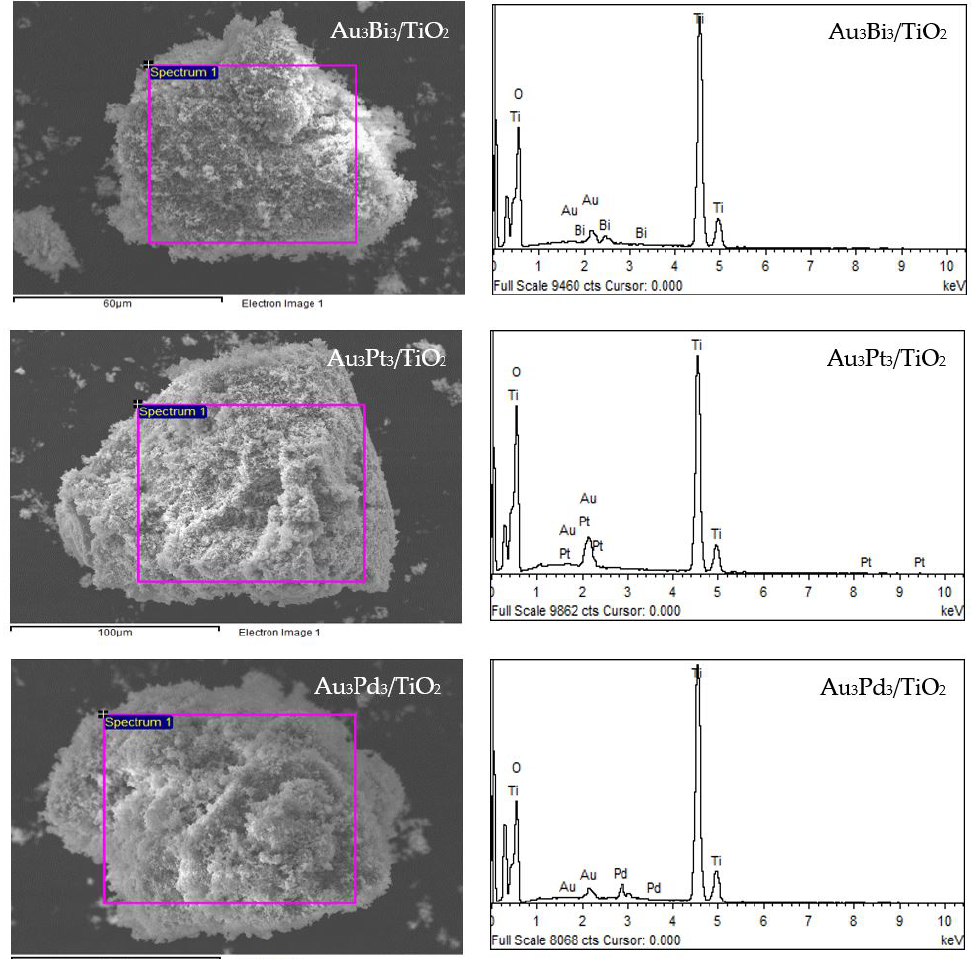
Figure 8. ( Left ) Representative SEM images of the different Au 3 M 3 /TiO 2 photocatalysts and ( Right ) EDS elemental analysis of the corresponding area shown in the rectangle on the SEM image.